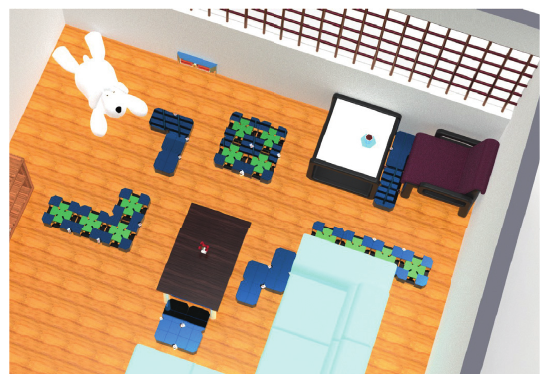
Figure 3: Operation of P-hTetro in a typical indoor environment. The robot shrinks its size in narrow spaces to improve the coverage. Similarly, the robot expands its size in free